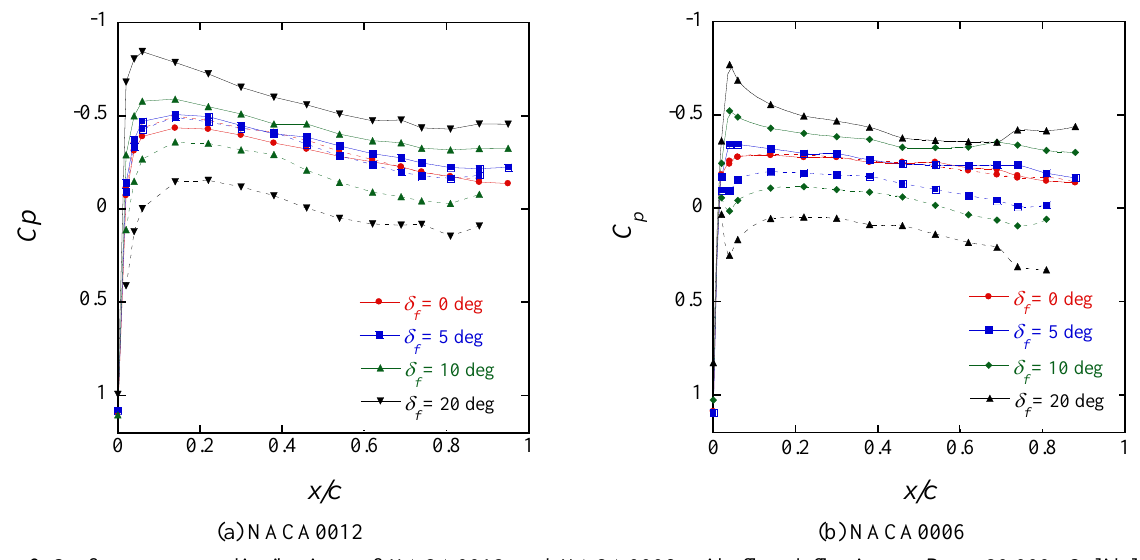
Fig. 9 Surface pressure distributions of NACA0012 and NACA0006 with flap deflection at Re = 20,000. Solid line indicates upper-surface pressure distribution and dashed line indicates lower-surface pressure distribution. The surface pressure begins to change after flow attaches to the lower surface as the flap angle increases. However, it undergoes very little change when flow separates both on the upper and lower surface even though the flap is deflected.